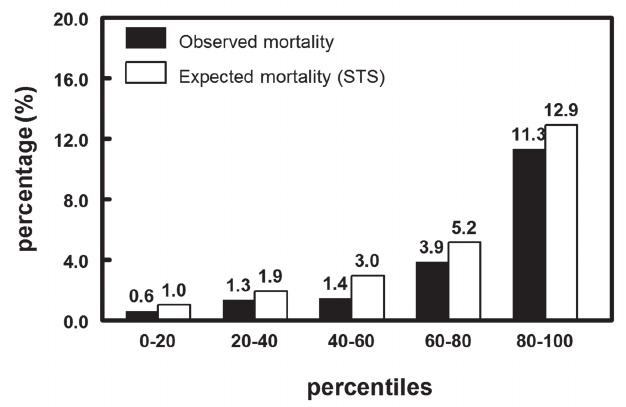
Fig. 1 – Observed and expected (mean) mortality rates divided by quintiles of expected mortality, as calculated by the STS scoring system. Goodness of fit Chi-square test has shown that the pattern of distribution of expected and observed mortality did not significantly differ in the study population (X 2 =1.06,